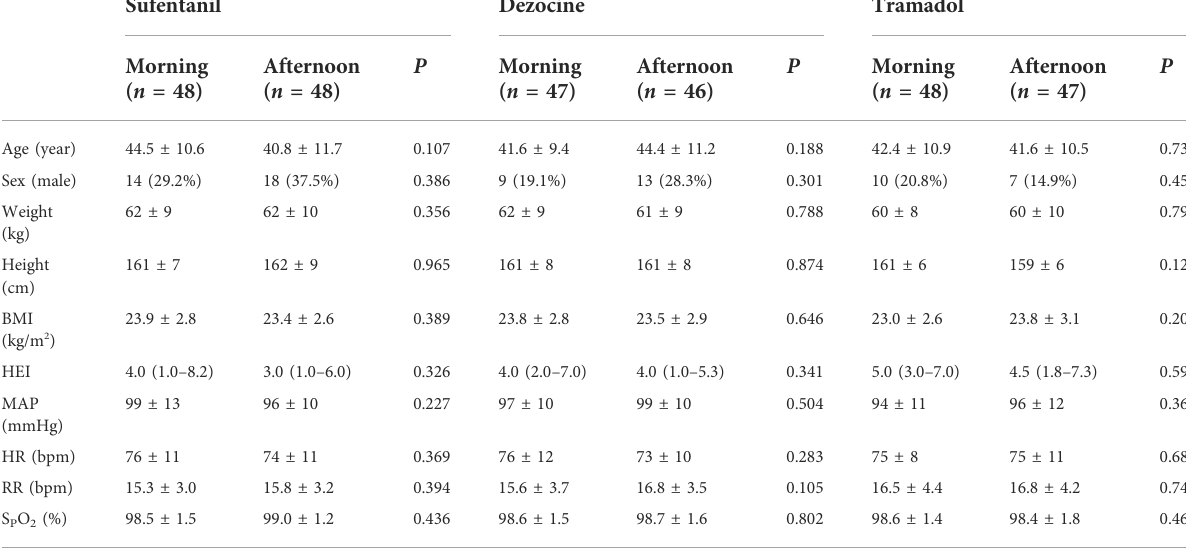
TABLE 1 Demographic and baseline characteristics for all included subjects in the morning and afternoon groups. Sufentanil